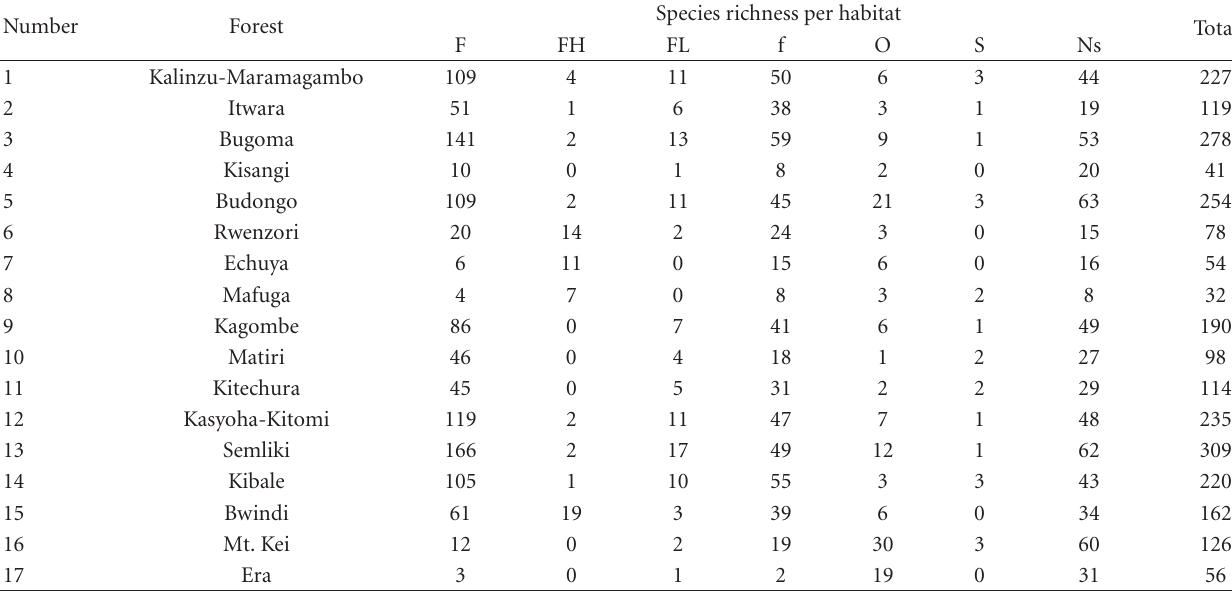
Table 2: Species richness in the 17 forests represented as ecological groupings.